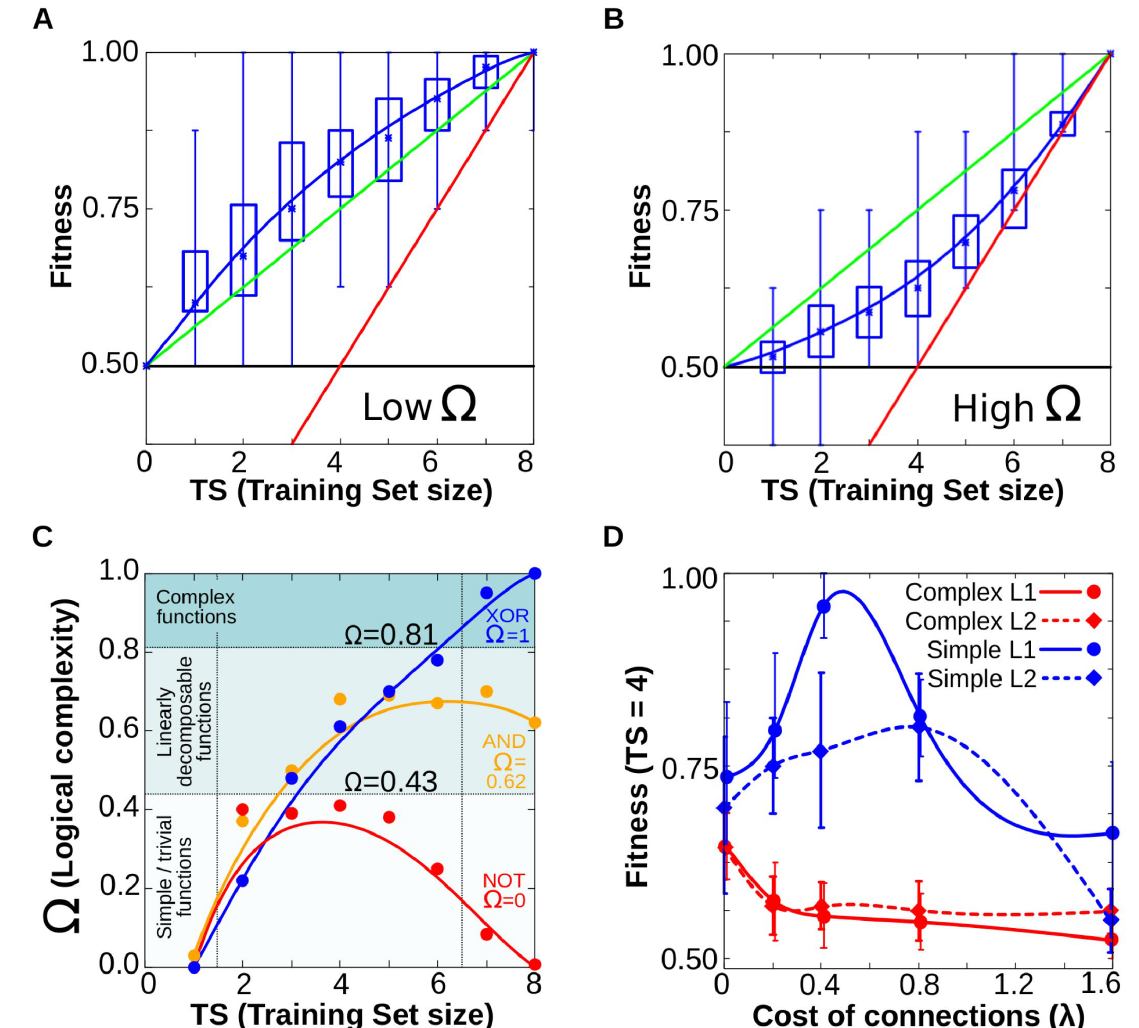
Fig 6. Generalisation experiments. A. When cells evolve simple forms of plasticity, they are able to generalise, performing better than chance in previously unseen environments (red line represents the information provided ( x = y ), green line represents the expected performance at random (2 Ne -TS )/2; and blue line the degree of matching between the resulting phenotypes and the expected ones for a given function). Notice that blue line runs consistently higher than the green line (random response). B. Similar experiments yield poor performances when cells have to evolve complex forms of plasticity (blue line below the green one, see main text). C. When cells have incomplete information about all possible environments (left), they acquire preferentially simple forms of cell plasticity. Acquiring complex forms of cell plasticity beyond linearly-decomposable functions (see SI) requires full information (blue line). In this panel, the complexity Ω of non-plastic functions was considered to be zero. D. Generalisation experiment under L 1 and L 2 regularization. For this experiment, plastic cells are only exposed to half of the possible environments ( TS = 4), that is the point where their inductive bias makes the result most different from randomness. We record how the ability of cells to generalise (to approach the maximum fitness of W = 8) changes as the cost of connections for the GRN increases (see Eq (8)). We do this for L and L regularisation procedures (solid and dashed lines respectively) which favour sparse and weak connections 1 2 respectively. We also show data for both complex ( Ω � 1, red lines) and simple ( Ω < 0.5, blue lines) plastic responses. The plot shows clearly how including a cost of connections improves drastically the performance of cells in generalisation experiments when cells are asked are evolved towards simple forms of plasticity. For all panels Ne = 3, Ng = 12, n = 30 replicates, standard deviation as boxes, min and max values as error